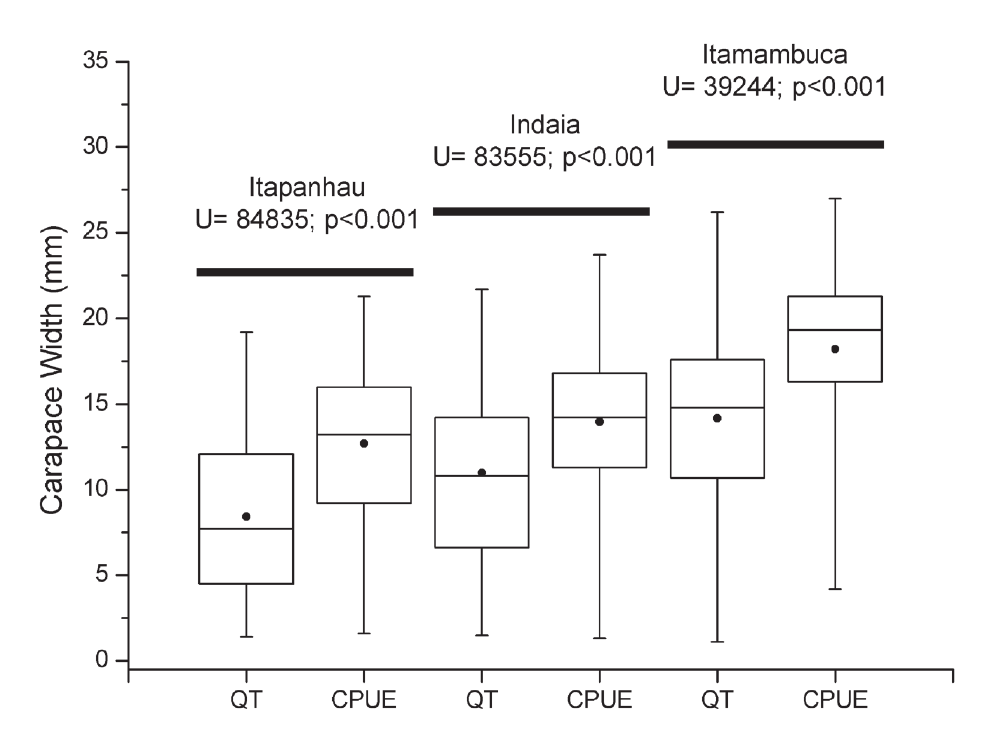
Figure 1. Minuca vocator (Herbst, 1804). Body size comparisons (CW mm) between sampling procedures, within each population (U – Mann-Whitney test). CPUE, catch-per-unit-effort. QT, quadrat technique. Mean, Median, 25–75%,